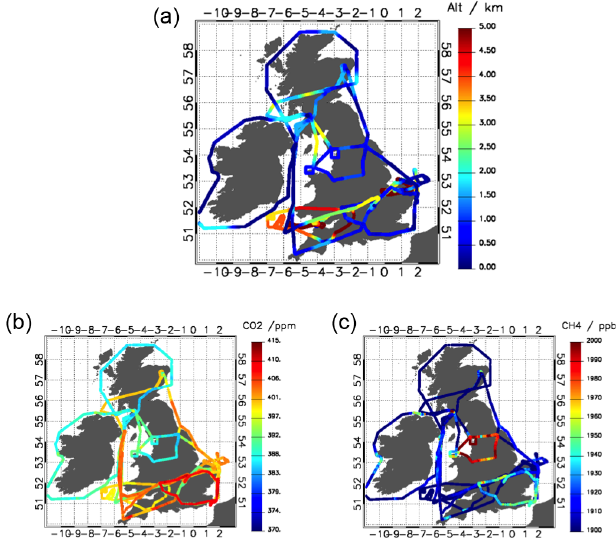
Figure 6. Flight tracks for all FAAM flights during GAUGE from 15 May 2014 to 4 April 2016 (Table 6). Colours denote (a) altitude, (b) CO 2 mole fraction, and (c) CH 4 mole